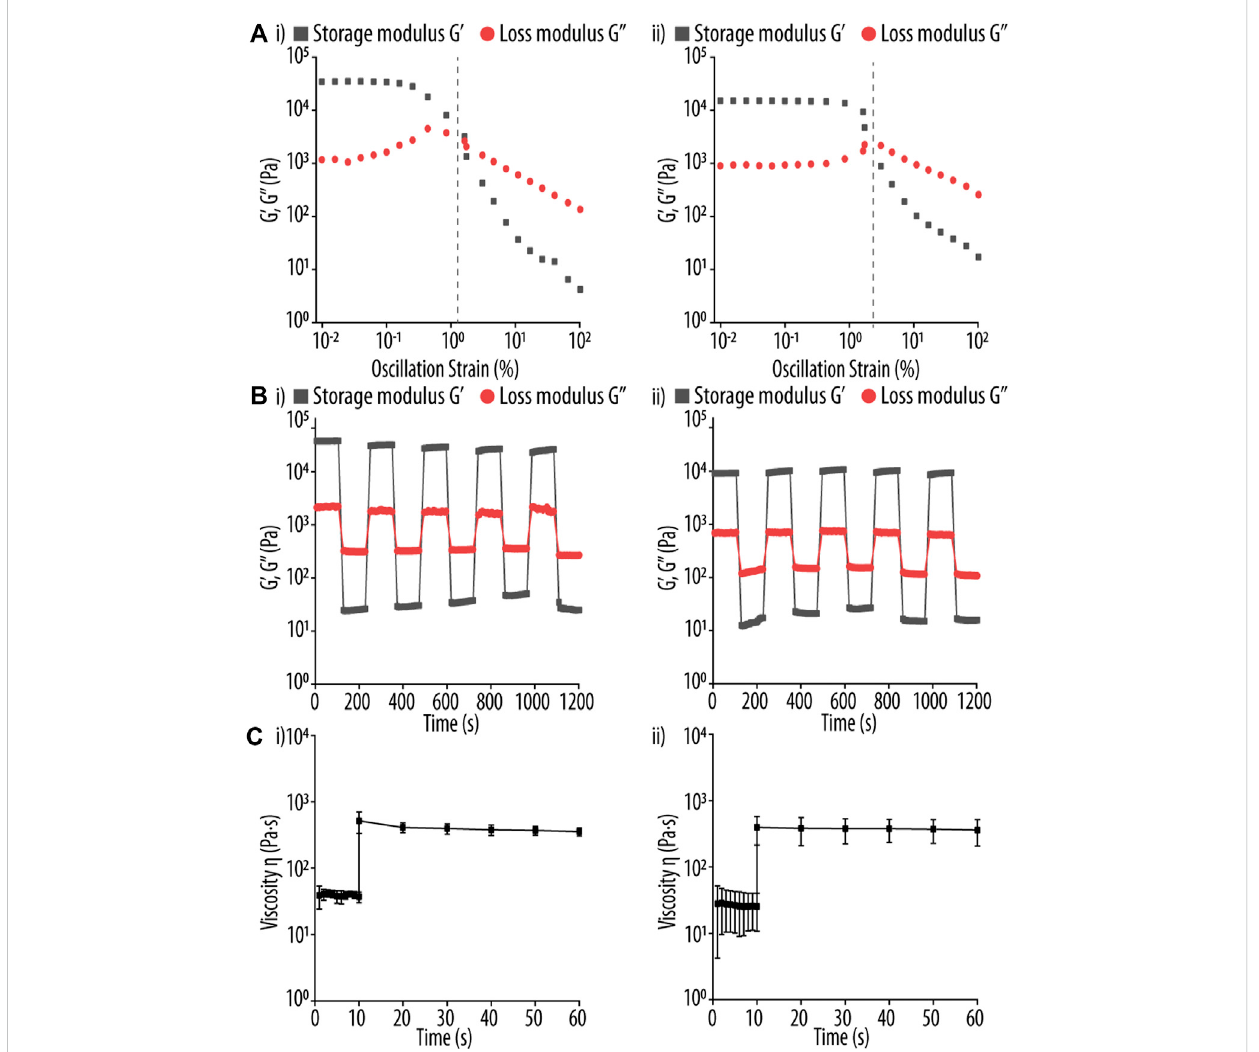
FIGURE 6 (A) Strain sweep test of guanosine (Guo)-based hydrogels using (I) boric acid (BA) and (ii) 2-naphtylboronic acid (NPBA). Storage modulus (G ′ , black square) and loss modulus (G ″ , red circle) were determined using a strain range of 0.01% – 100% and a fi xed oscillation frequency of 1 Hz. The respective turning point of both Guo-BA and Guo-NPBA hydrogels formulations in indicated by a vertical gray dashed line. (B) Rheological test of Guo-based hydrogelsusing(i)BA,and(ii)NPBAat37 ° C.TheG ′ andG ″ ofthehydrogelsareshownusingastrainamplitudeof0.1%and100%fortherecoveryand shear step, respectively, and a fi xed angular frequency of 10 rad s − 1 . Each interval was constant at 100 s. (C) Rheological test of Guo-based hydrogels using(i)BAand(ii)NPBAat37 ° C.Ashearstressof3.45 s − 1 wasappliedfor10 s,mimickingtheconditionsduringthreedimensional(3D)-printing,andthen the hydrogels were allowed to recover for up to 50 s at 0.1 s − 1